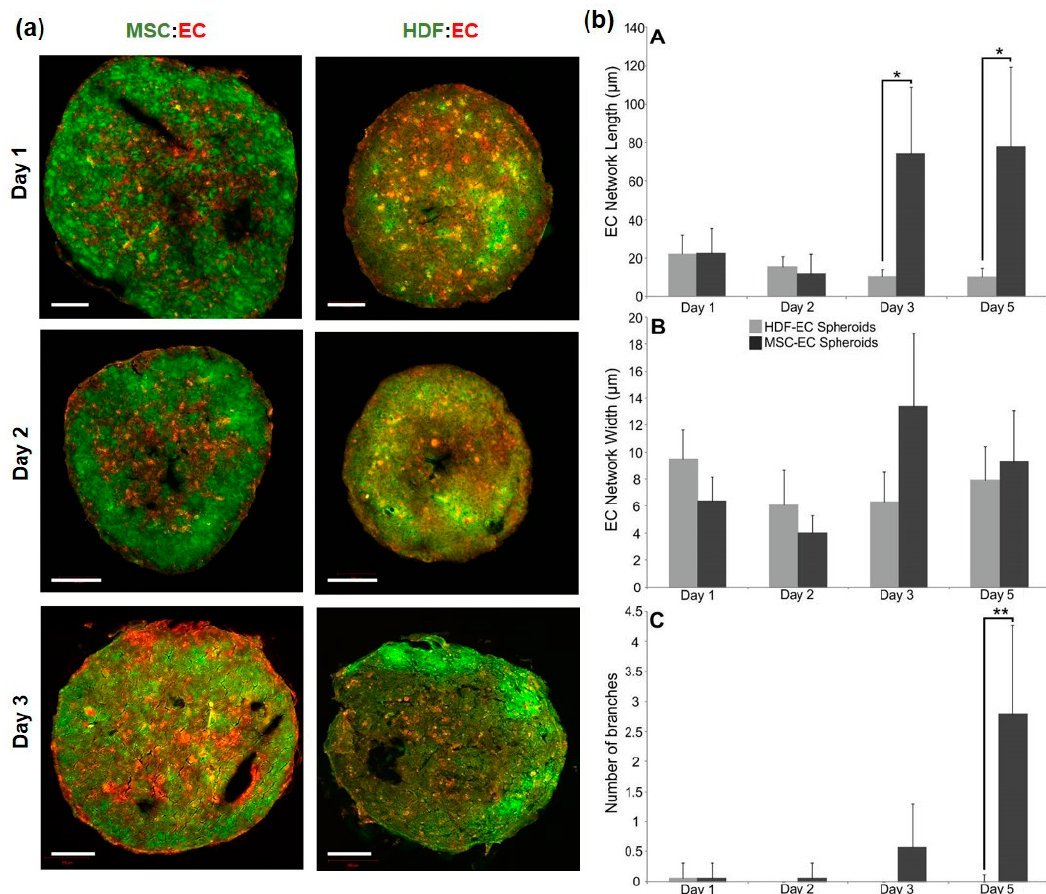
Figure 2. Self-organisation in fluorescently labelled HDF-EC and MSC-EC spheroids. ( a ) Sections of MSC:EC and HDF:EC spheroids grown over 3 days in culture; MSCs or HDFs were labelled green and ECs were labelled red. Scale bars = 100 µ m ( b ) Quantification of EC network length (A, top), width (B, middle) and branching (C, bottom) using image analysis.